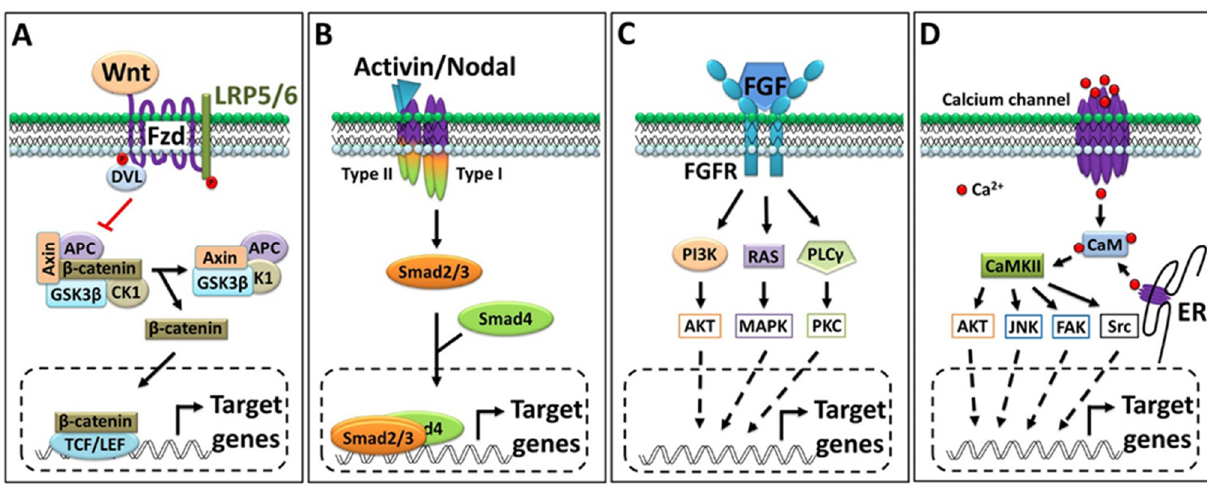
Figure 2. Outline of key signaling pathways. ( A ) Canonical Wnt signaling pathway; on a signal (Wnt) input, Dvl inactivate the destruction complex and releases β-catenin. β-catenin translocates into the nucleus, where it can interact with a transcription factor to regulate the target gene’s expression. ( B ) Activin/Nodal signaling pathway. Activin and Nodal bind to the same set of receptors that activate the intracellular domain of the receptor and sequentially activate Smad2/3. ( C ) FGF signaling pathway: depending on the ligand, FGFR activates different types of cytosolic effector proteins. ( D ) Ca 2+ signaling pathway: intracellular calcium interacts with a calcium binding protein that activates intracellular protein kinase and ultimately regulates the target gene’s expression via several sets of transcription factors .